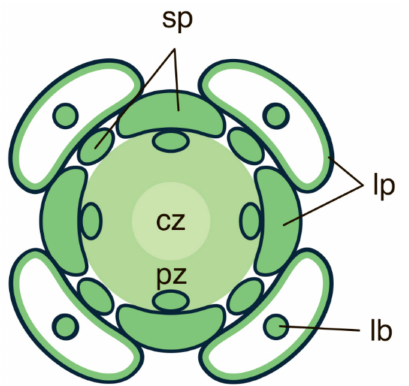
Figure 4. Expression pattern of YABBY homologs in lycophytes. Scheme is based on descriptions and photos of in situ RNA-RNA hybridizations from [36]. cz—central zone of the SAM, pz—peripheral zone of the SAM, lp—leaf primordium,